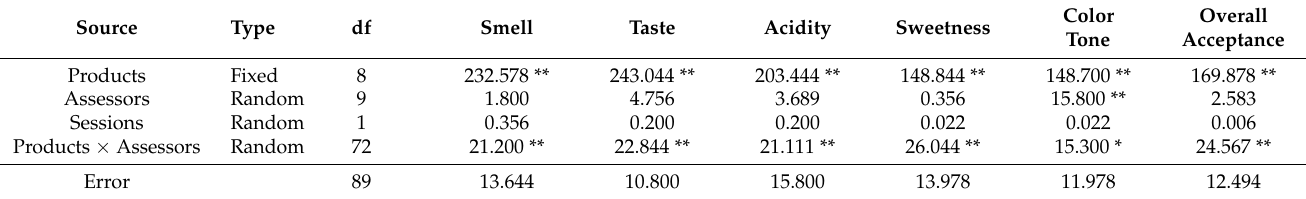
Table 7. ANOVA table of panel analysis parameters (type III sum of squares analysis).